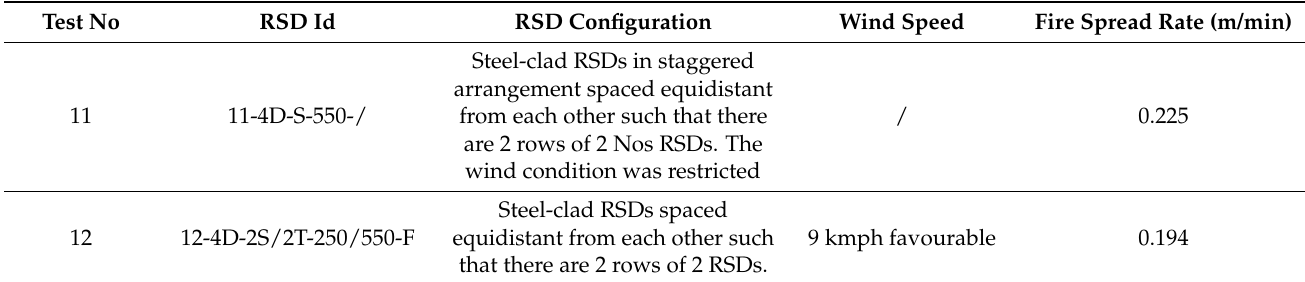
Table 8. Testing matrix of four RSD